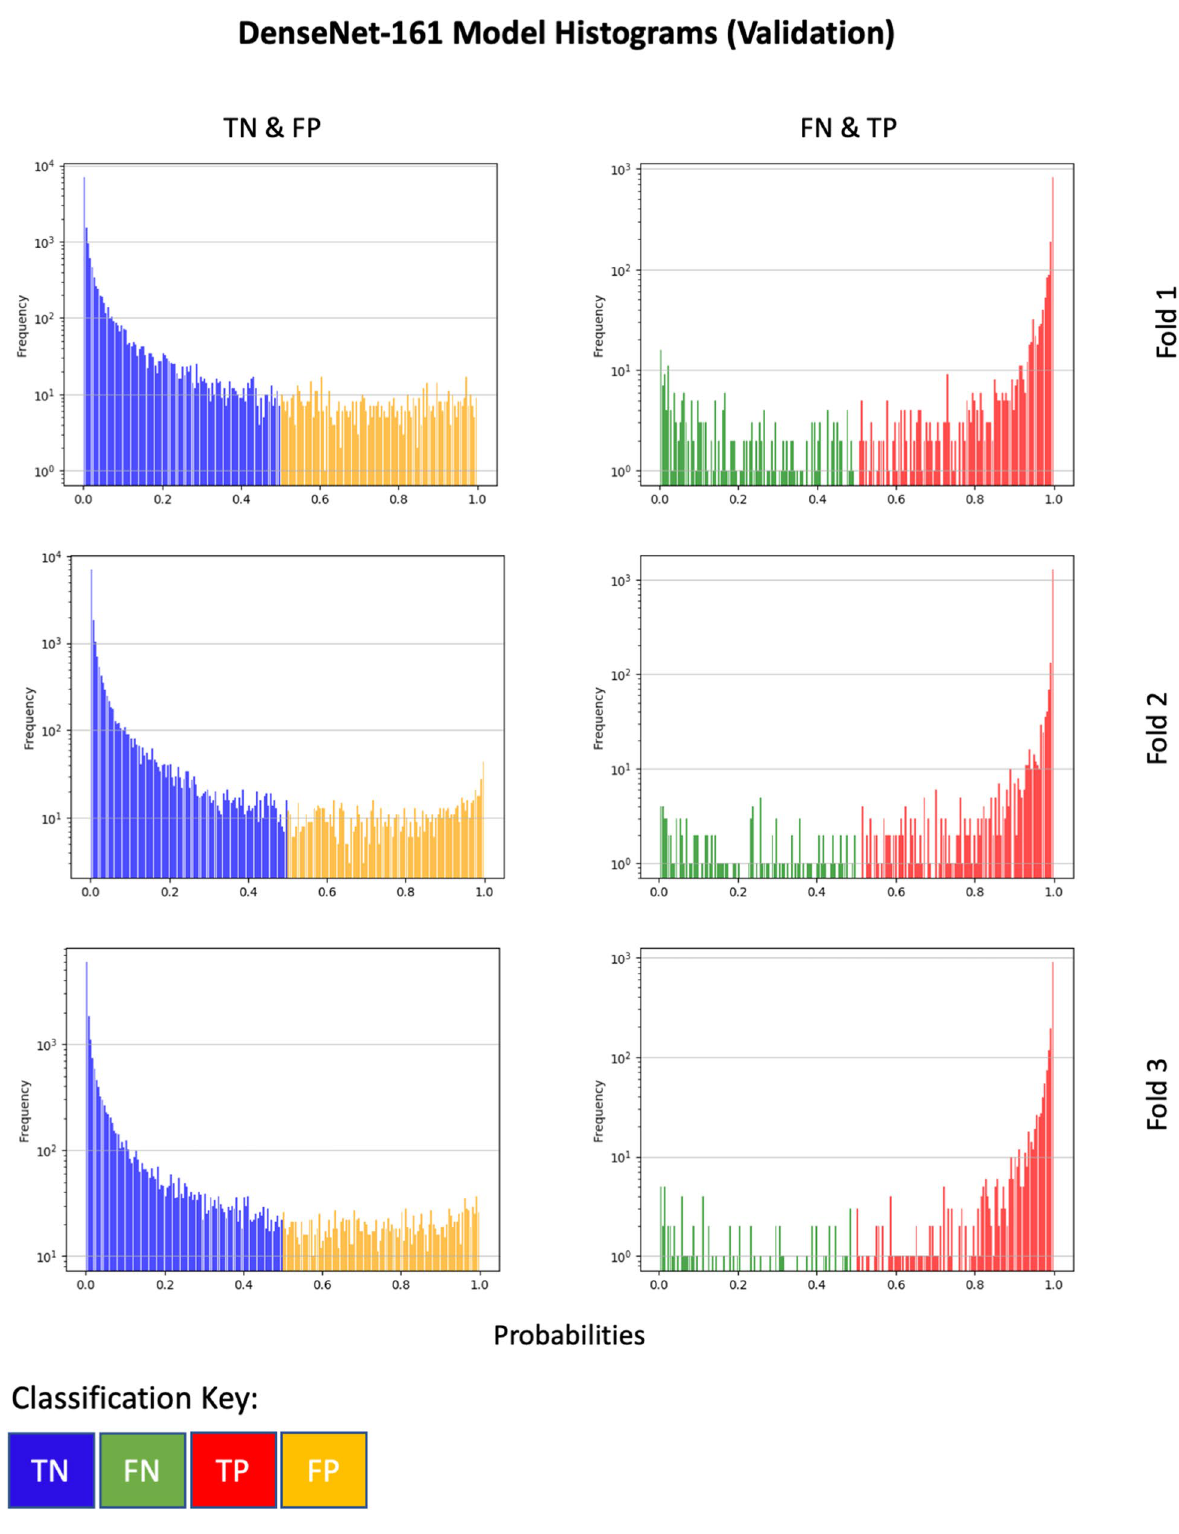
Figure 3. Histograms of the initial classification results based on a standard 0.5 (50%) probability decision threshold. Depicted are true negatives (TN), false positives (FP), false negatives (FN) and true positives (TP) for the DenseNet-161 model. On the left side depicts histogram plots of TN and FP for each validation fold, whereas on the right side depicts histogram plots of FN and TP. These combinations were chosen for the plots as they complement each other. It can be seen that all three folds are characteristically similar in distribution. TN and TP predictions typically produce high probabilities, as can be seen by the frequency of such predicted probabilities. Increasing the probability threshold would increase the number of true negatives and reduce the number of false positives. However, this would subsequently increase the number of false negatives and reduce the number of true